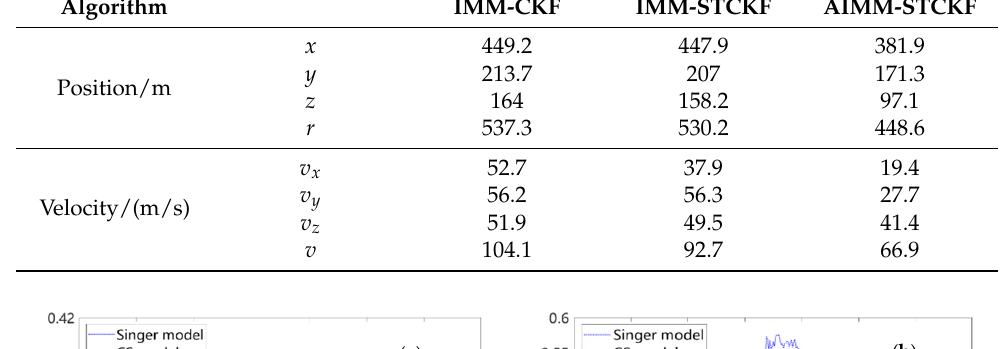
Figure 11. Velocity RMSE of three algorithms: ( a ) RMSE of velocity in the x-axis direction; the RMSE is about 400 m/s; ( b ) RMSE of velocity in the y-axis direction; ( c ) RMSE of velocity in the z-axis direction; ( d ) RMSE of velocity.